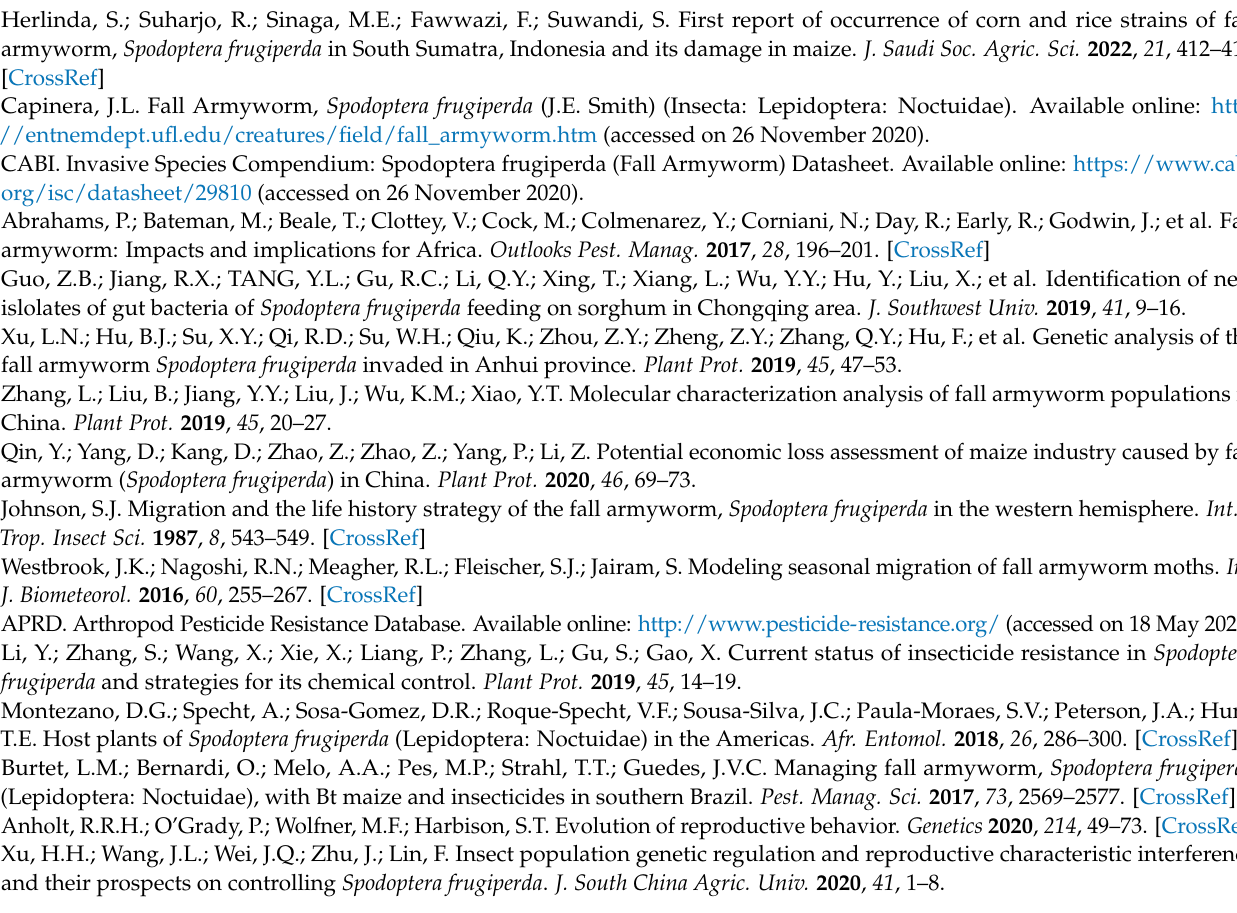
Table S13: Important soma maintenance related DEGs enriched by GO or KEGG enrichment analyses in S. frugiperda males. Video S1: Reproductive behavior of paired S. frugiperda . References [81–123] are cited in the supplementary